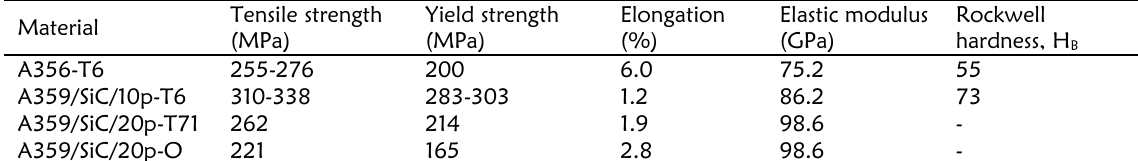
Table 2: Mechanical properties of permanent-mold cast Al-SiC MMCs [25].